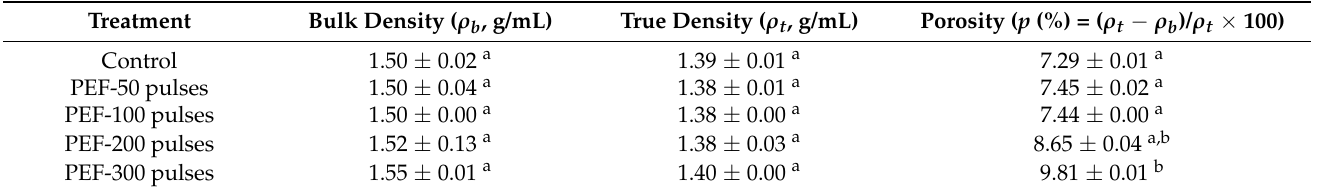
Table 2. Density and porosity of soaked glutinous rice grains with or without PEF treatment.